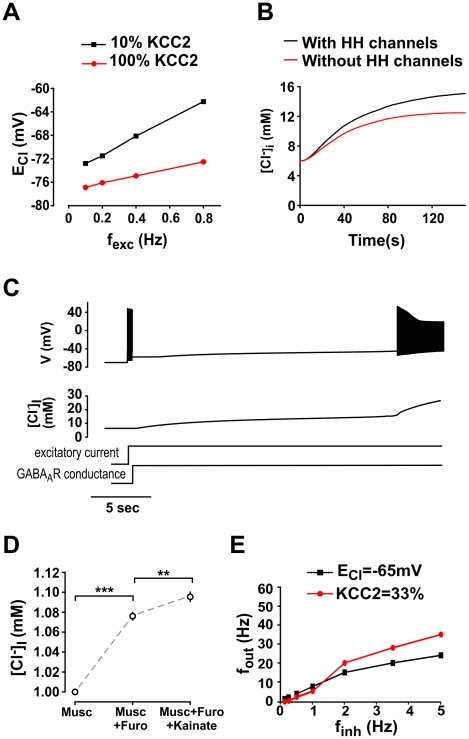
Effects of membrane potential on intracellular Cl− accumulation.
A. Varying the rate of excitatory synaptic drive (f
exc) caused a depolarizing shift in E
Cl secondary to changes in average membrane potential. f
inh was fixed at 0.4 Hz. B. Spiking exacerbates intracellular Cl− accumulation as illustrated here by convergence of the model to different steady state [Cl−]i depending on whether the model does or does not contain HH channels (i.e. does or does not spike, respectively). For this simulation, KCC2 activity was low (10%), f
inh  =  0.8 Hz, and f
exc  =  0.4 Hz. C. Sample traces showing inter-relationship between [Cl−]i and spiking. Neuron began spiking when constant excitatory current was applied to the soma, but without any concomitant change in [Cl−]i since there was not yet any GABAAR-mediated conductance. Turning on constant GABAAR conductance in the soma terminated spiking, but at the expense of intracellular Cl− accumulation. Chloride slowly accumulated over the next several seconds until membrane potential reached spike threshold, at which point spiking resumed and Cl− began a second phase of accelerated accumulation. D. To test whether Cl− accumulation is exacerbated by excitatory synaptic input in real neurons, somatic Cl− concentration was measured using FLIM in neurons with or without glutamatergic receptor activation by kainate. As predicted by simulations, Cl− accumulation was greater in neurons exposed to kainate. Furosemide was applied to block KCC2 activity in these experiments (**, p < 0.001; ***, p < 0.0001). Data from 56 cells from 5 coverslips. E. Comparison of input-output curve for static (black) vs. dynamic (red) E
Cl. Discrepancies between the curves clearly demonstrate that E
Cl cannot be approximated as constant value when considering a range of input conditions.